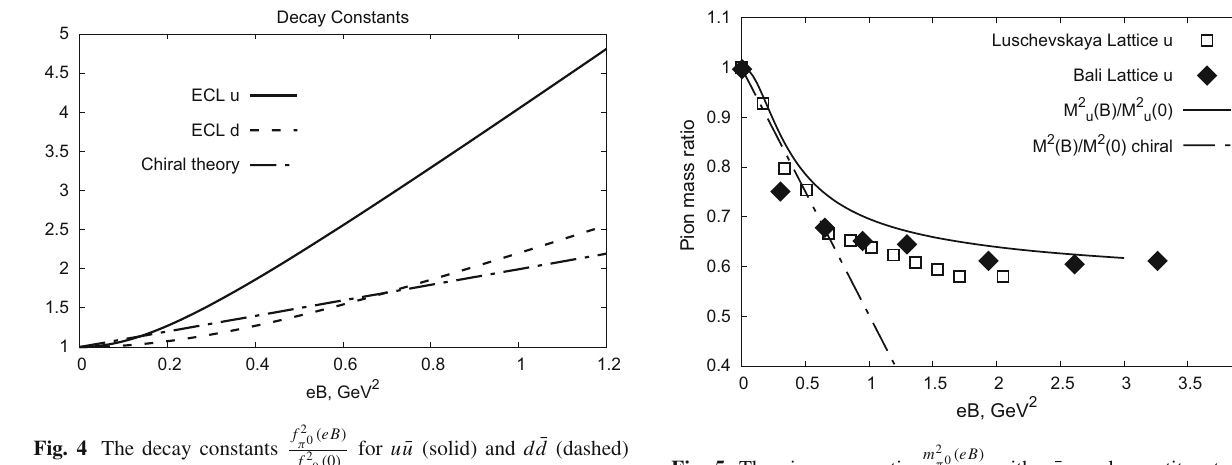
Fig. 5 The pion mass ratio culated with ECL (solid line) in comparison with the lattice data from [31,32] (dots) and with the standard chiral perturbation theory predic- tion from [10]